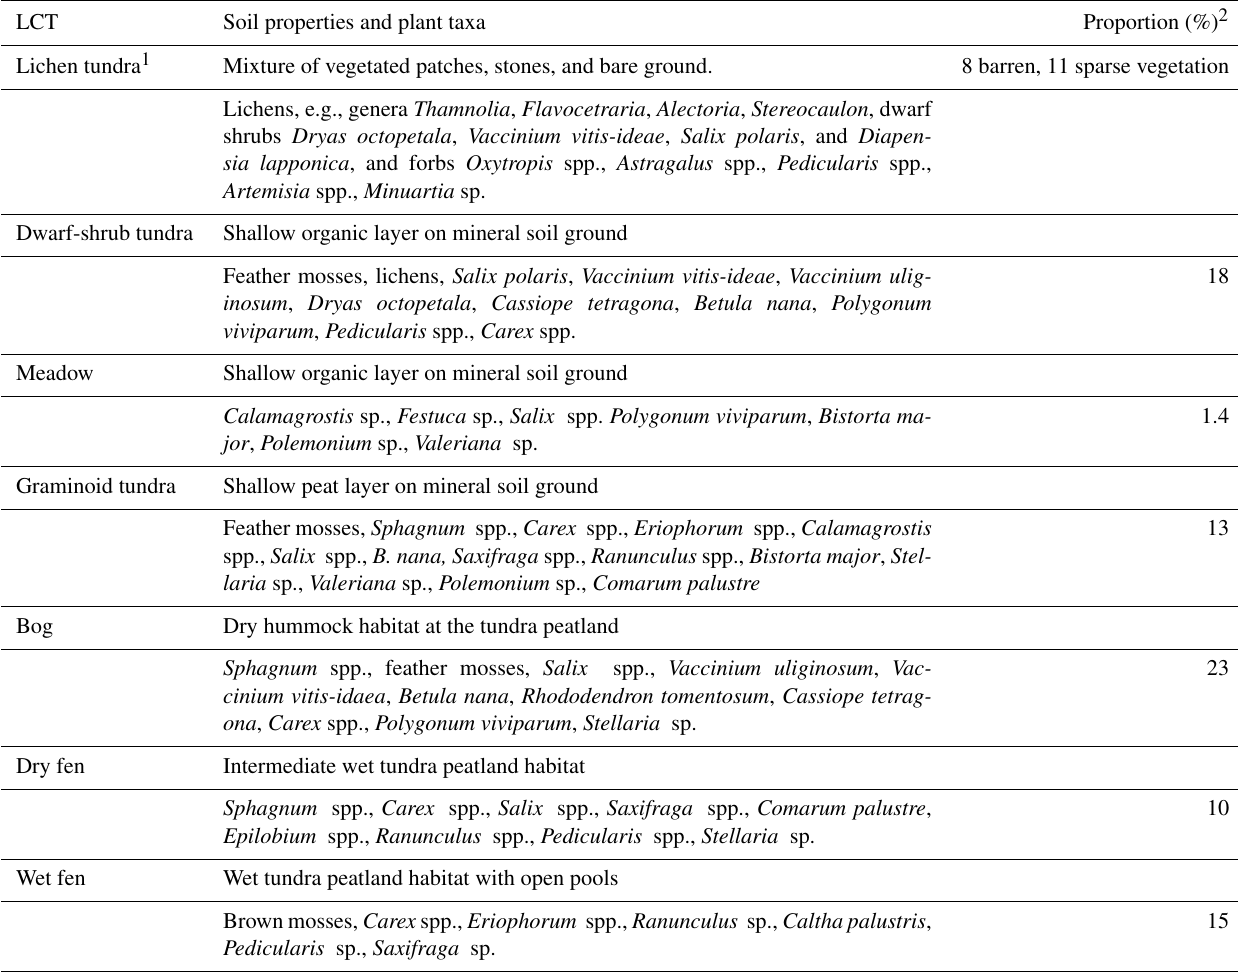
Table 1. Soil and vegetation characteristics of the land cover types (LCT) and their proportions in the EC impact area (90% of the cumulative